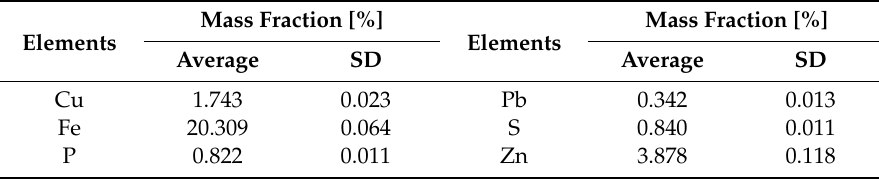
Table 1. Elementar chemistry of sludge sediment determined by XRF